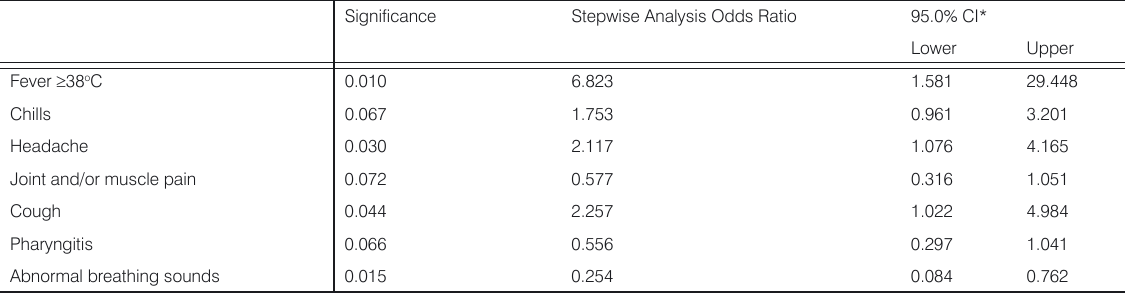
Table 4. Multivariate predictors of influenza infection in